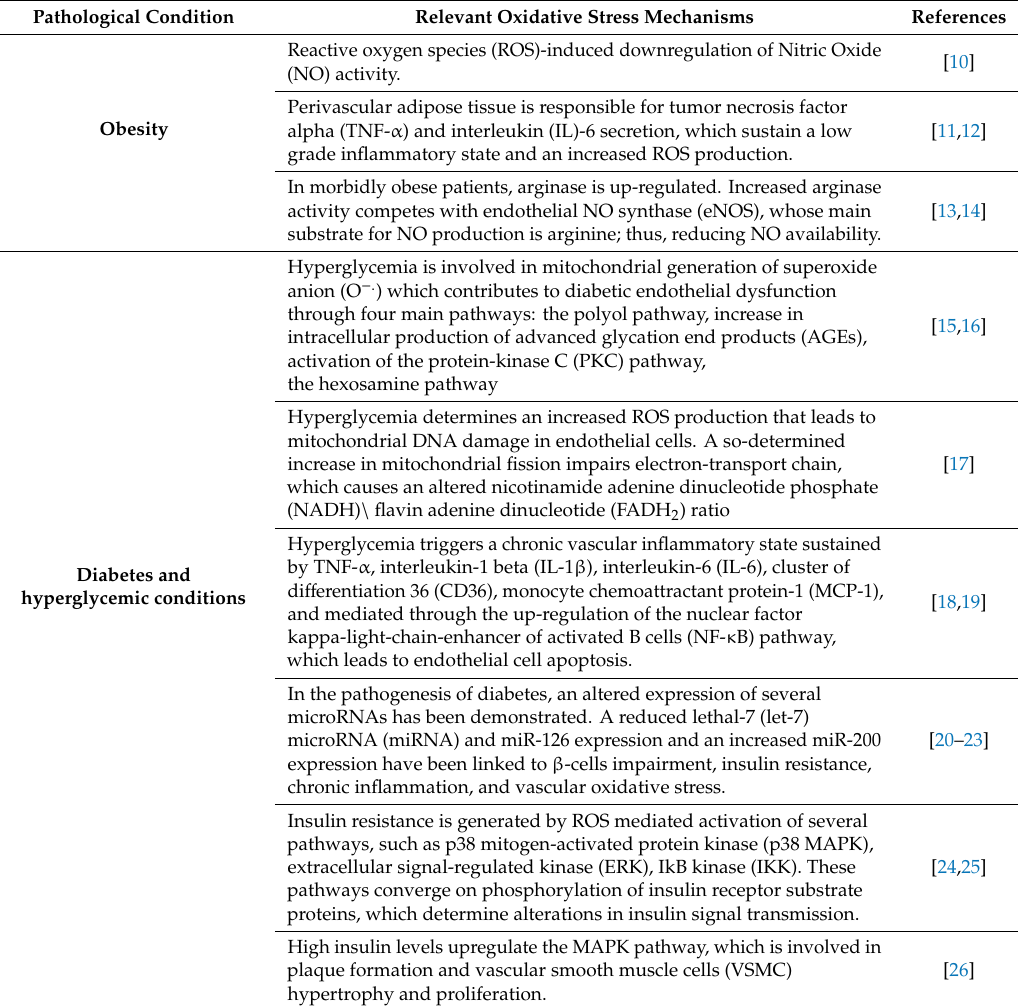
Table 1. Oxidative stress mechanisms in cardiovascular